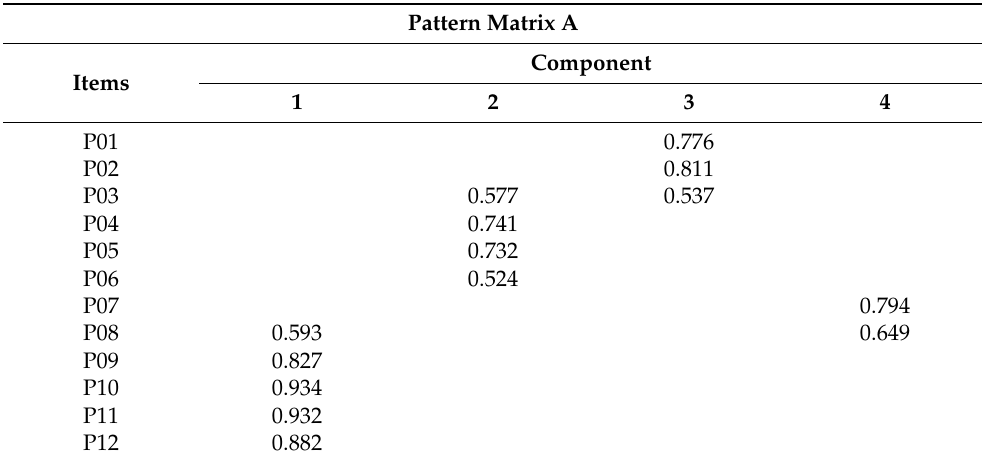
Table 6. Matrix of rotated components for four factors.